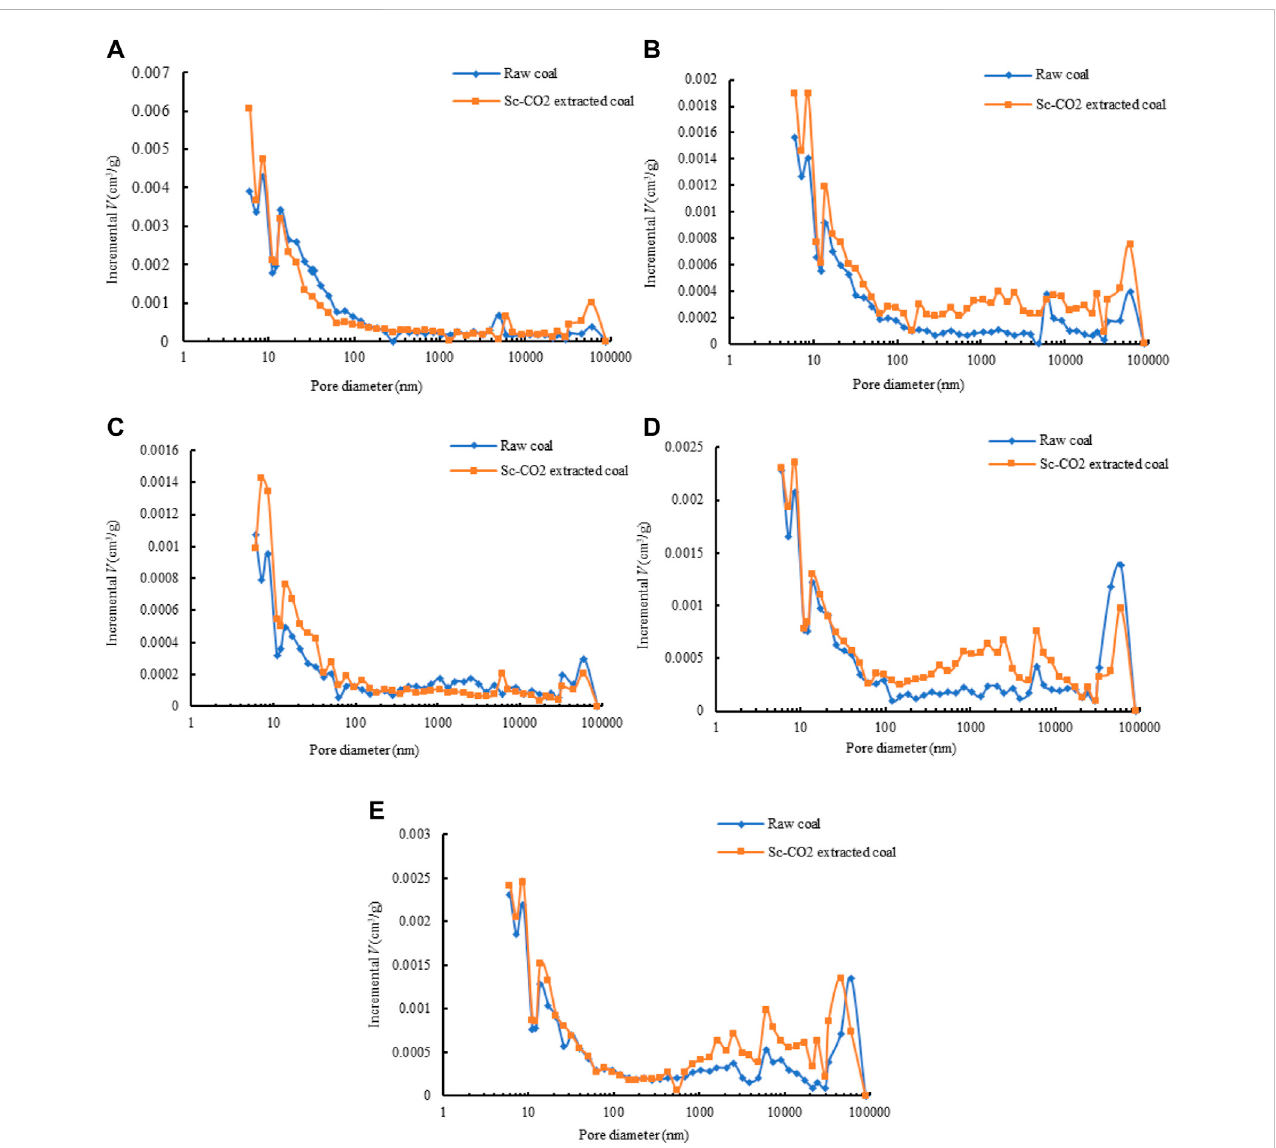
Pore volume distribution of the coal samples before and after Sc-CO 2 extraction (A) SJG coal; (B) LJZ coal; (C) LL coal; (D) CJW coal; and (E) SSP